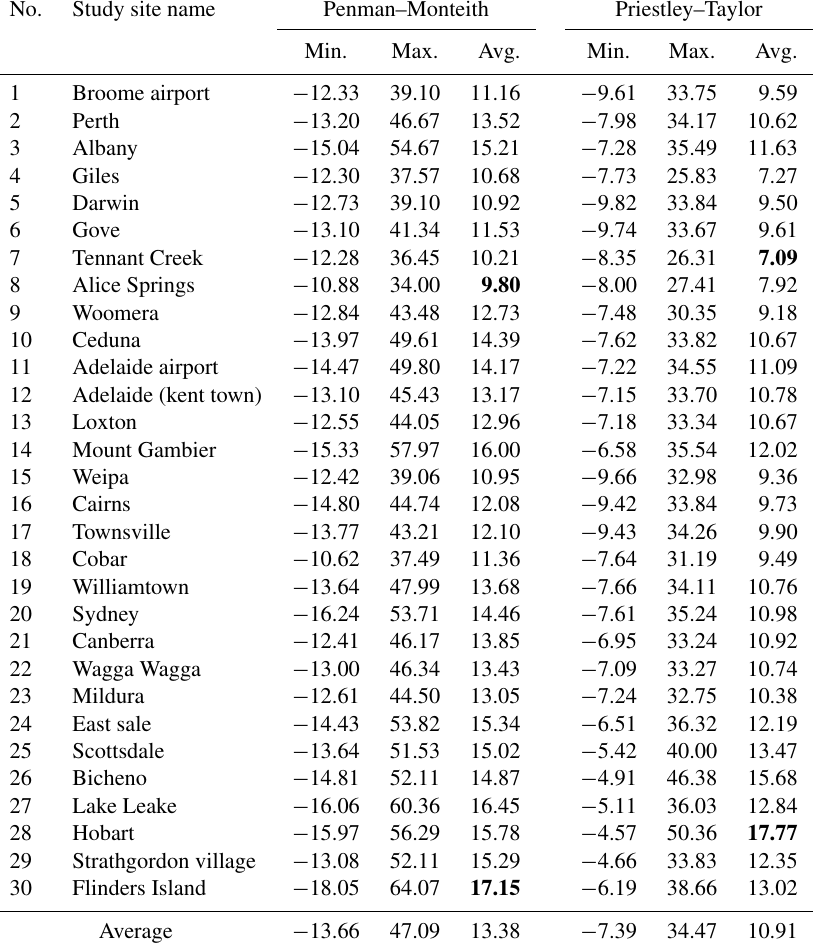
Table 3. Maximum, minimum and average of all possible changes in annual average PET in response to the full set of climate perturbations from the Penman–Monteith and Priestley–Taylor models at the 30 study sites (as % changes to baseline PET relative to the 1995–2004 base- line). The maximum and minimum changes from each model across all locations are in